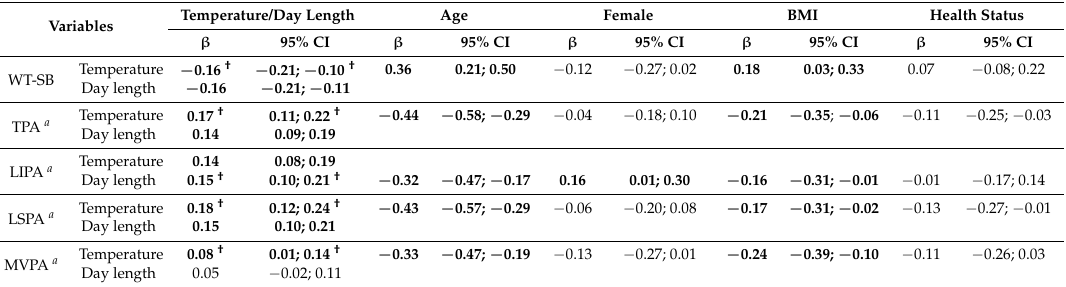
Table 2. Results of the ANCOVA for of PA and SB parameters for the 138 participants with complete data during summer and winter. Covariates included age, sex, BMI, self-reported health status, day length, and temperature. Data are presented as standardized β ( β ), 95% confidence interval (95% CI). None of the included covariates affected the standardized as for the two seasonal variables, Temperature and Day length. A negative β value indicates an inverse relationship. Significance ( p < 0.05) are shown in bold. Two separate models were run for each variable, where only one seasonal variable (temperature or day length) was in each model; seasonal variables with higher β are marked with † . Other variables were included in both models but are shown in the table only for the model with the higher β of the seasonal